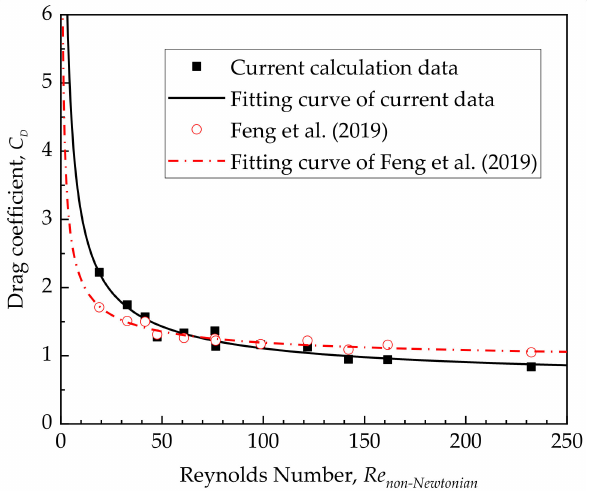
Figure 5. Comparison between current calculations and previous experimental results.